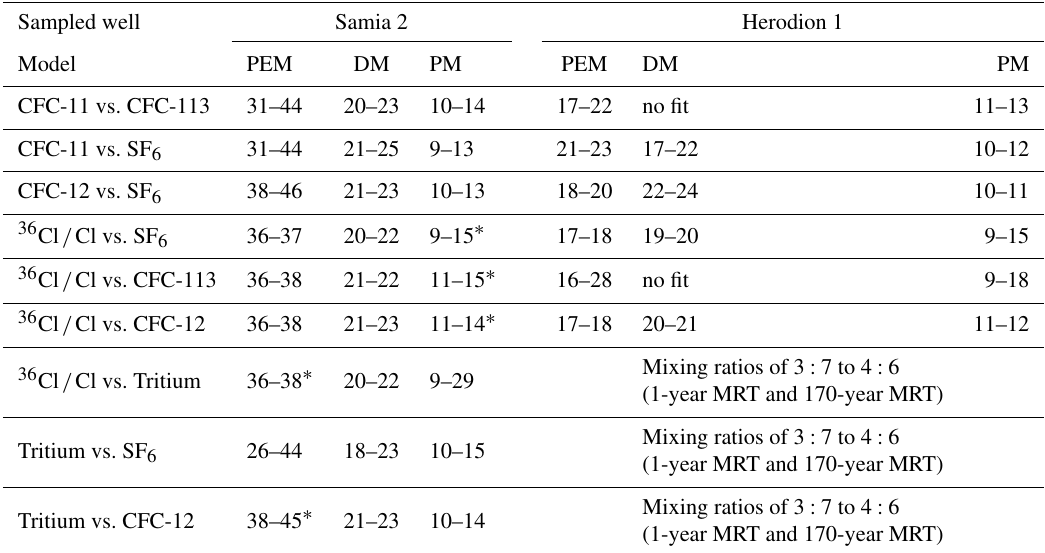
Table 4. Summary of modelled MRTs of Samia 2 and Herodion 1 extracted from different tracer combinations. PM: piston flow model; DM: dispersion model; PEM: partial exponential model. ∗ Estimated